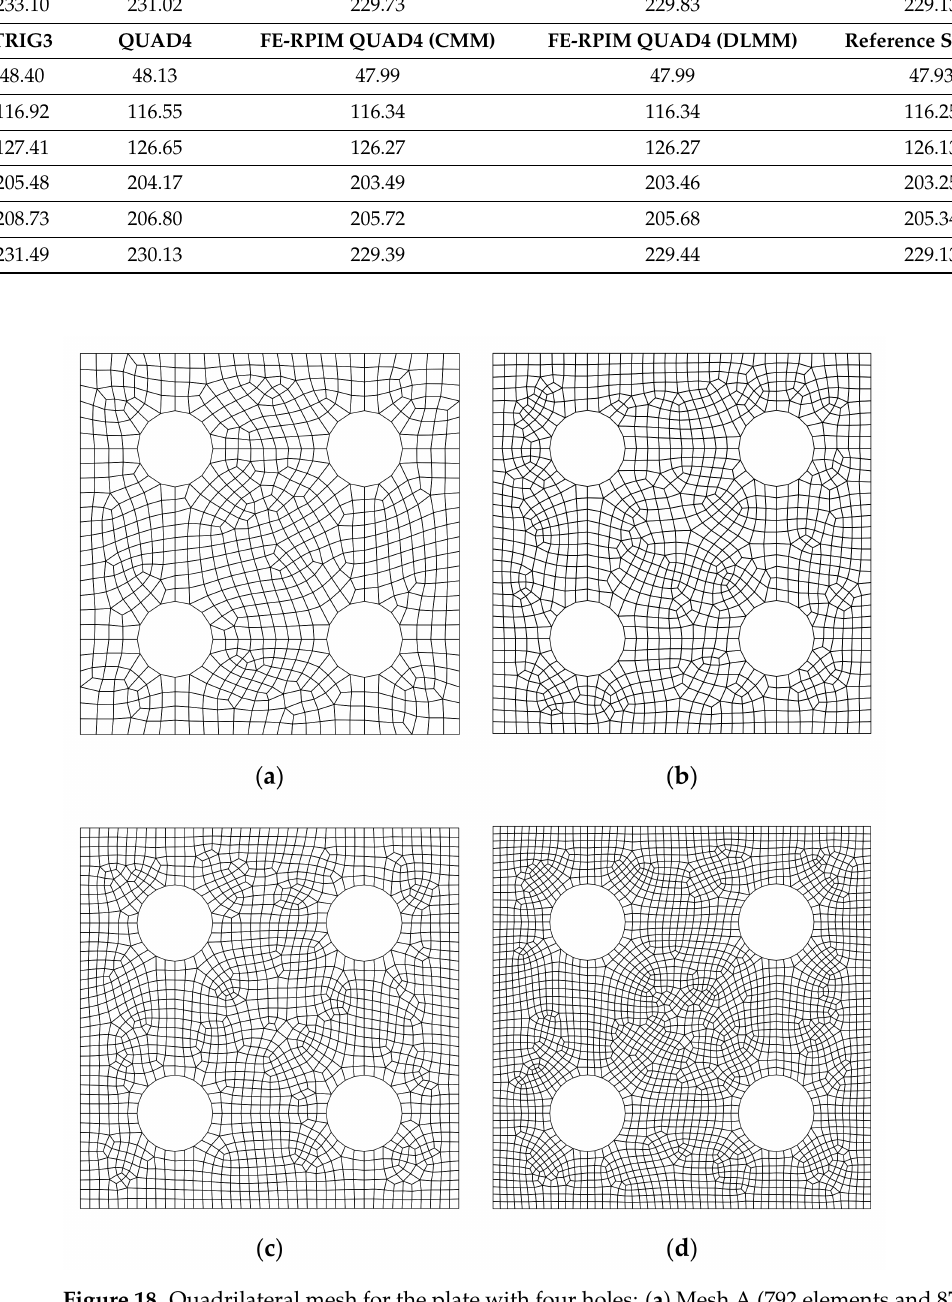
Figure 18. Quadrilateral mesh for the plate with four holes: ( a ) Mesh A (792 elements and 871 nodes); ( b ) Mesh B (1175 elements and 1278 nodes); ( c ) Mesh C (1585 elements and 1710 nodes); ( d ) Mesh D (2651 elements and 2814